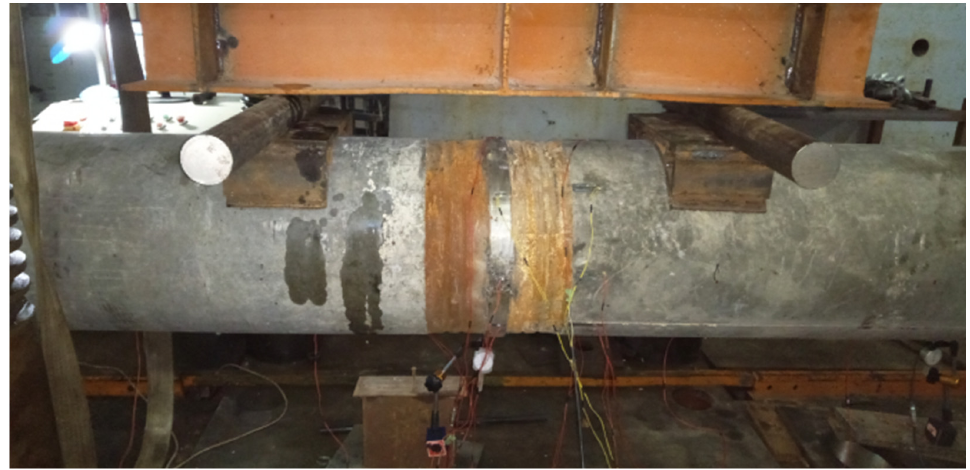
Figure 7. Bending test setup and instruments photograph.